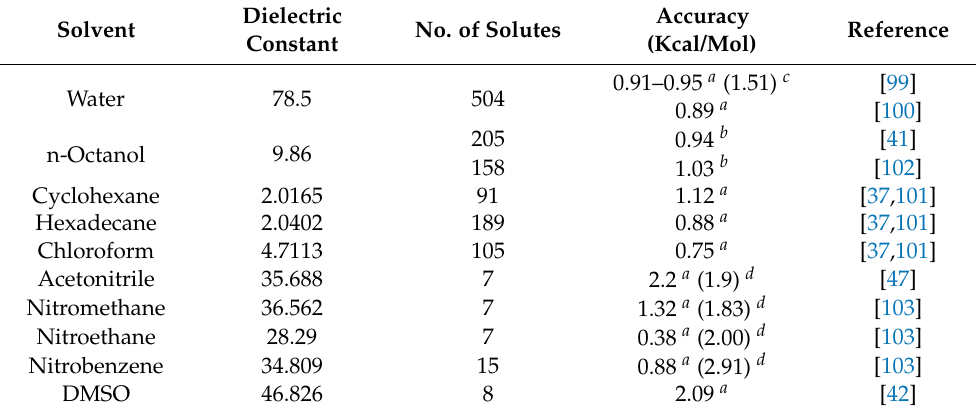
Table 1. Performance of the 3D-RISM-KH theory in predicting solvation free energy of solutes in various solvents reported in the literature. Performance of different computational method in solvation free energy calculation is provided in